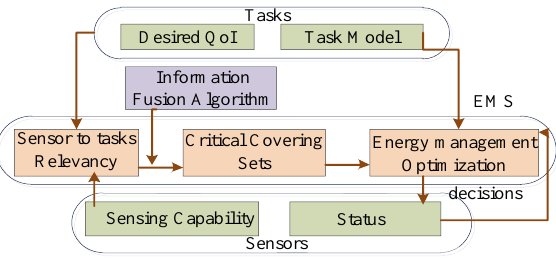
Figure 8. Flow of an energy management framework.